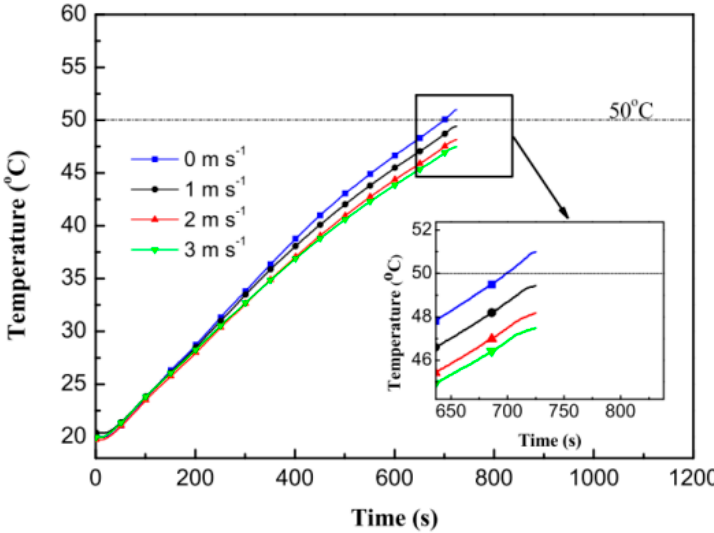
Figure 9. Transient temperatures under different air velocities at a 5 C discharge rate (from Wu et al. [56], with permission from Elsevier).